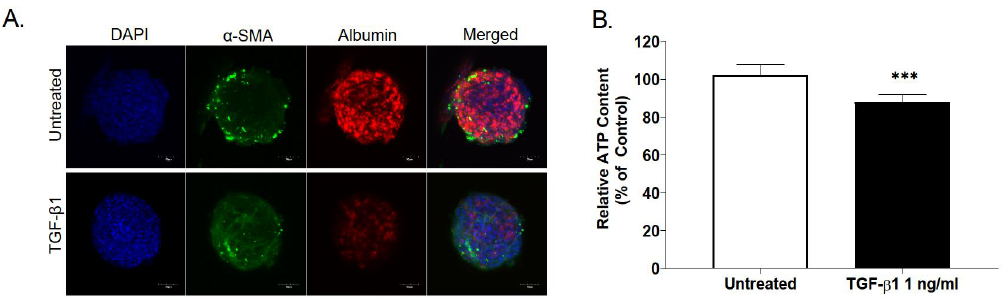
Figure 6. Effects of the pro-fibrotic cytokine TGF- β 1 on human liver microtissues. MTs were exposed to TGF- β 1 (1 ng/mL) for 48 h. Immunostaining of treated and untreated MTs was carried out: DAPI (blue), α -SMA (green) and albumin (red), 20× magnification ( A ), scale bar is 50 µm. Albumin staining was used to assess HepaRG function, whereas the formation of α -SMA fibers indicate the activation of hTERT-HSC in the treated MTs. CellTiter-Glo ® Luminescent Cell Viability Assay was used to measure relative ATP of TGF- β1 treated MTs in comparison to untreated. Data represent mean ± SD ( n = 9) ( B ). Statistical analysis using unpaired s tudent’s t -test: ***: p ≤ 0.001.